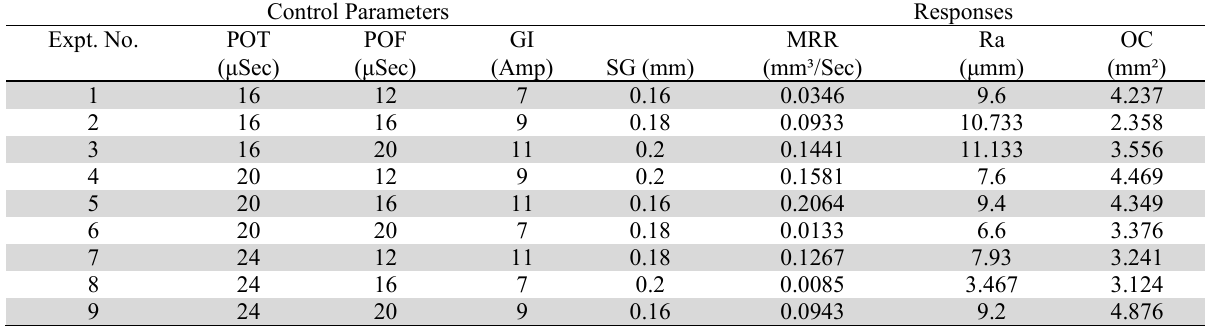
Parametric settings and responses for experimental run Control Parameters Responses Expt. No.